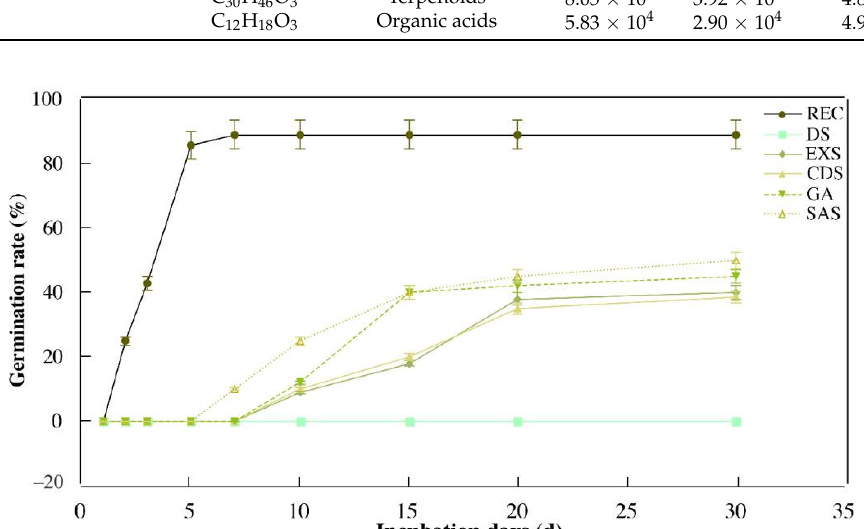
Figure 10. Variations in the germination rate of Chinese pistache seeds under different treatments. BS, imbibed seeds; EXS, exotesta-removed seeds; SAS, concentrated sulfuric acid-soaked seeds; REC, seeds with the exotesta and 1/2 cotyledon removed; GA, seeds treated with 100 mg/L GA 3 ; and CDS, seeds treated with stratified wet sand at 4 C for approximately 100 days.